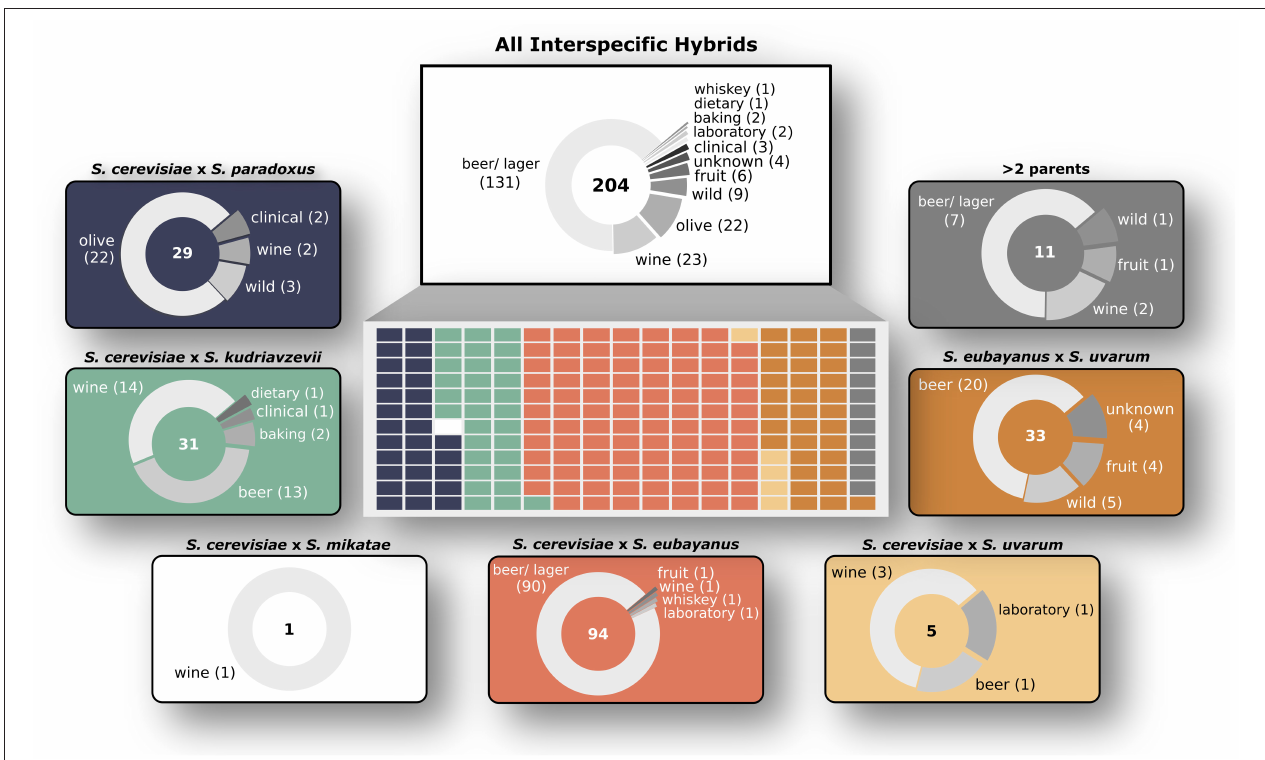
FIGURE 1 | Overview of Saccharomyces interspecific hybrid genomes. Sampling origins of the 204 interspecific hybrid strains analyzed in this study are indicated in the top white box. Strains are divided by parent species ancestries in the central rectangle with each smaller rectangle representing a single hybrid genome, colored according to its ancestry. The seven different hybrid crosses are shown in outer boxes with sampling origins as pie charts. The total number of genomes for each cross is shown in the center of each pie